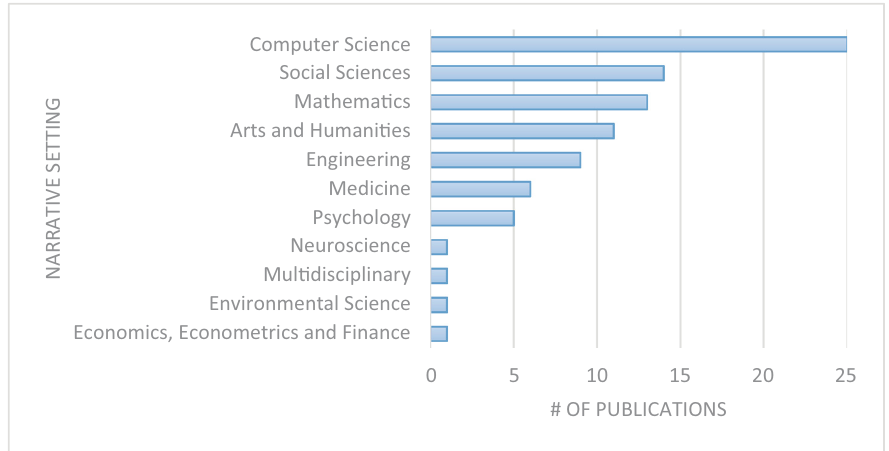
Figure 5: Sex robot - coded narrative settings based on academic discipline ( Scopus ) .